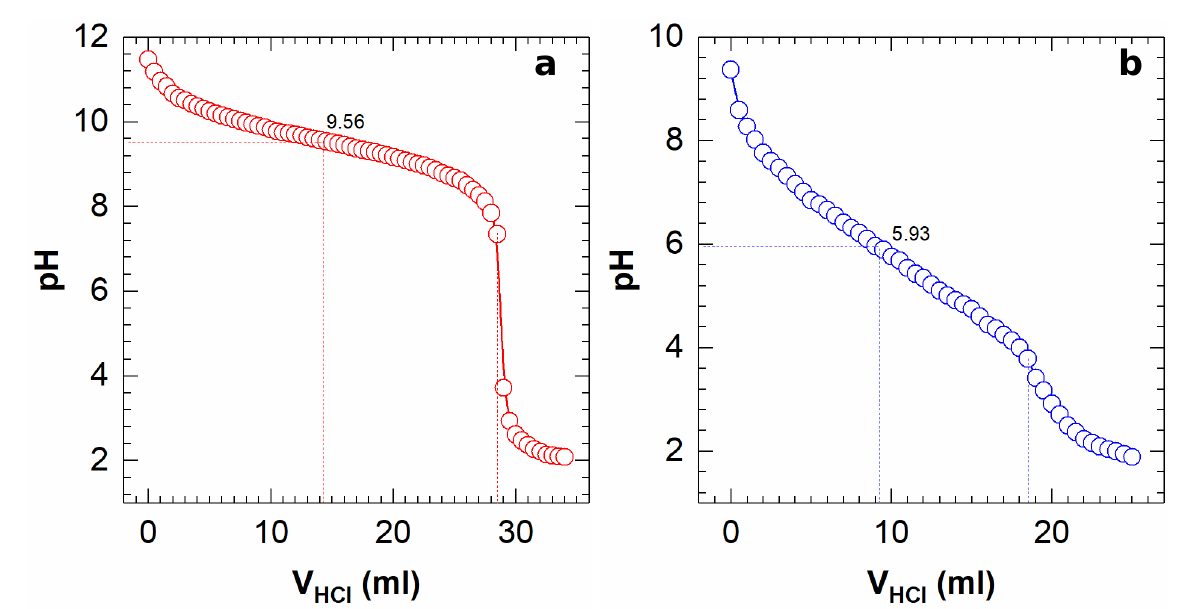
Figure 6. pH titration curves of ( a ) DMEA and ( b ) NaPAA aqueous solutions against 0.1 M HCl at 25 °C.